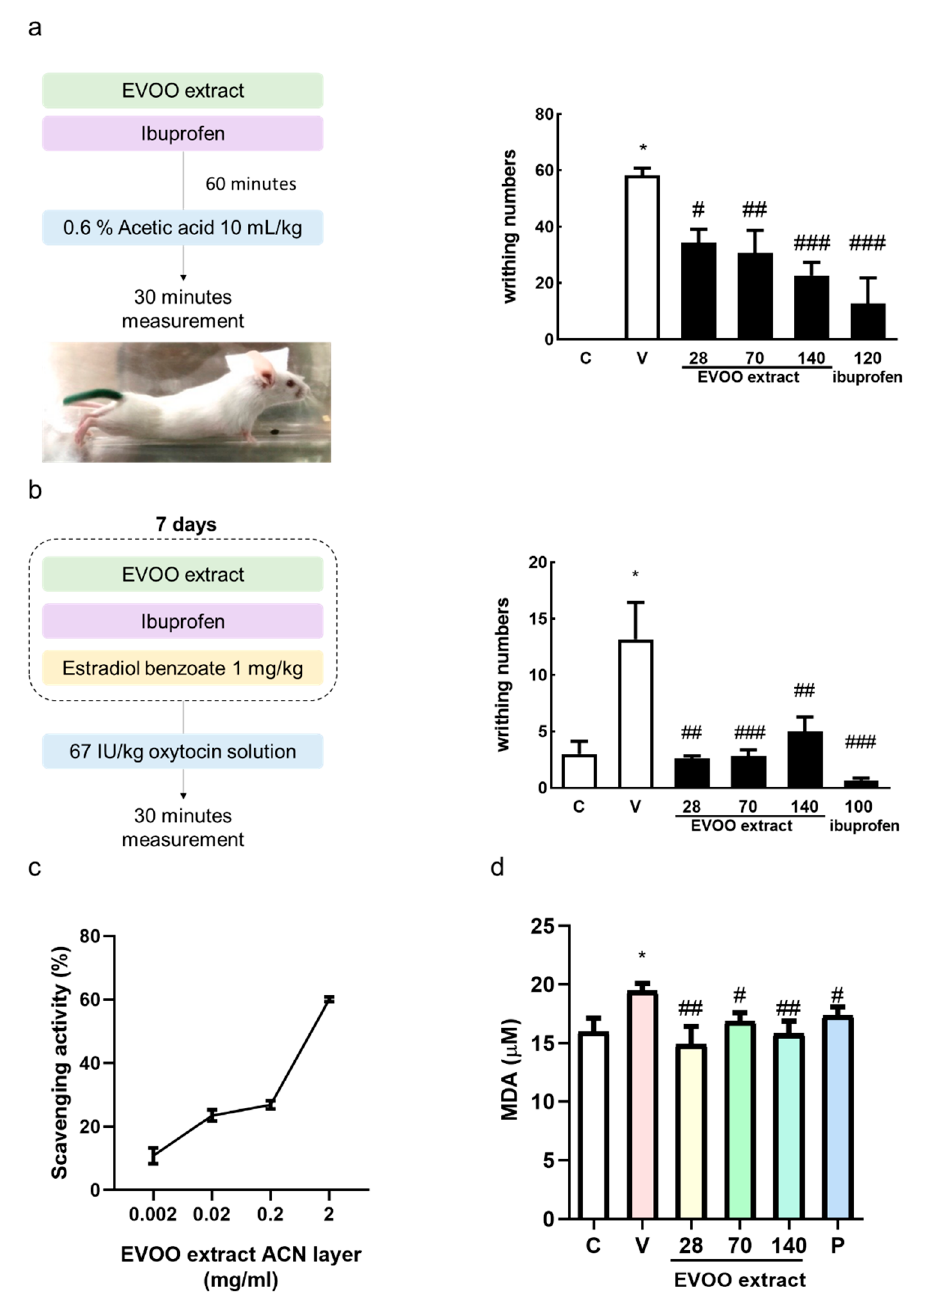
Figure 5. Effect of extra virgin olive oil (EVOO) extracts on acetic acid or oxytocin-induced writhing responses in mice. Mice were treated with EVOO extracts and ibuprofen (mg / kg, oral gavage), and we used ( a ) acetic acid injection, except for the control group, or ( b ) oxytocin injection. The amount of writhing was counted for 30 min after acetic acid administration. ( c ) 2,2-Diphenyl-1-Picrylhydrazyl (DPPH) scavenging activity and ( d ) malondialdehyde (MDA) concentration. Data are presented as the mean ± standard error of mean (SEM) ( n = 5). * p < 0.05 versus control group, # p < 0.05, ## p < 0.01, ### p < 0.001 versus vehicle group. C, Control; V, Vehicle (67 IU / kg oxytocin). ACN: Acetonitrile.